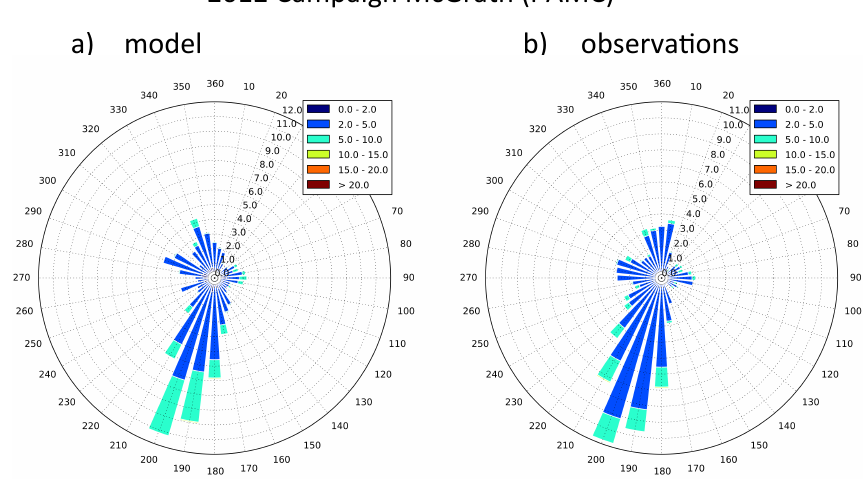
Figure 9. As in Fig. 5, but for McGrath, AK. Table 5. 2012 campaign model bias/RMSE for upper-level variables for WRF